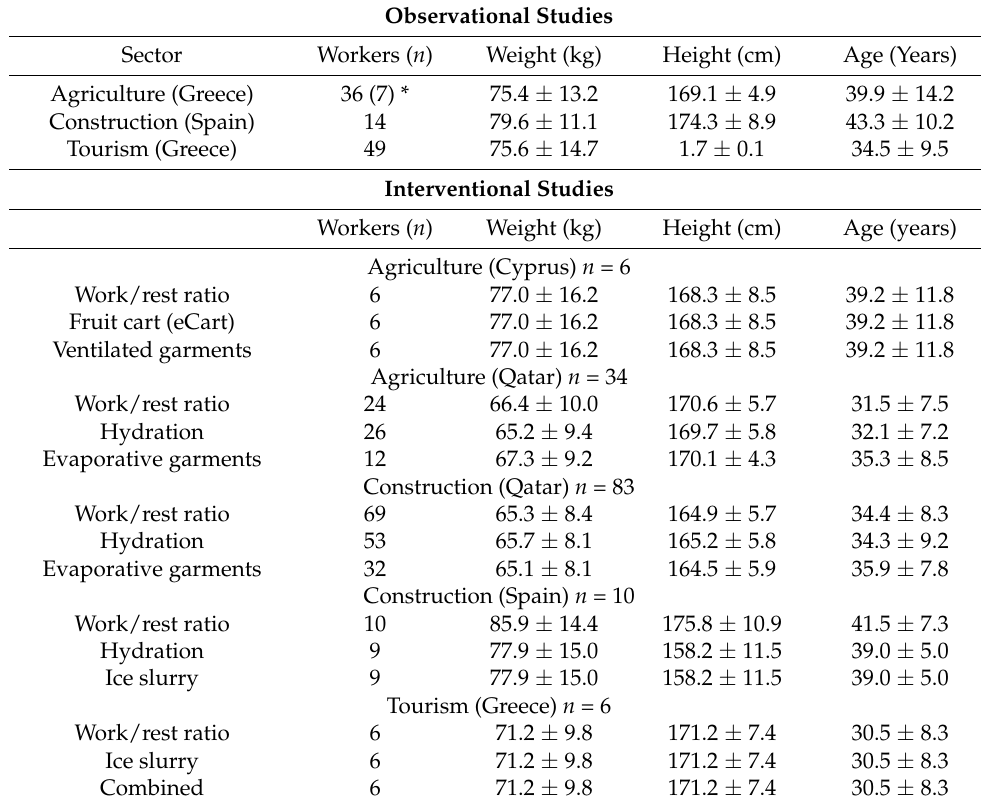
Table 1. Workers’ personal characteristics (mean ± SD). Asterisk indicates that no anthropometric data were collected from all